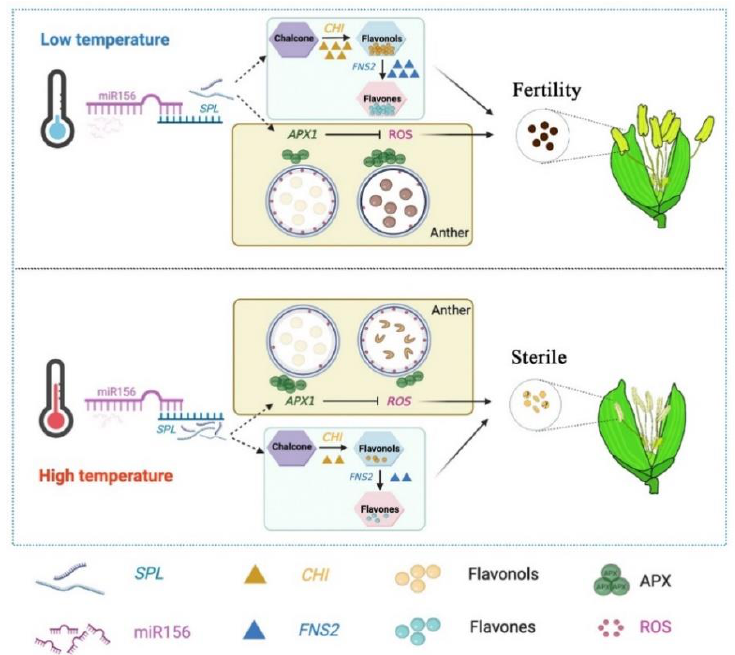
Figure 11. A model for OsSPL response to temperature change and involvement in the regulation of rice fertility. Under low temperature conditions, the miR156- OsSPL module regulated CHI expression in response to temperature changes, resulting in a strong synthesis of flavonols and flavones in the flavonoid pathway, providing sufficient flavonoid substances for the formation of fertile pollen. In addition, the miR156- OsSPL module regulates APX1 gene expression and controls the PCD process in the tapetum by affecting the APX-ROS balance, providing the material basis for the formation of fertile pollen.